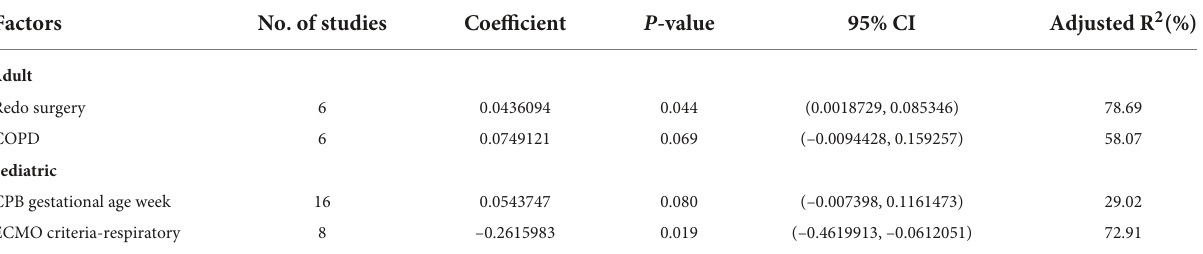
TABLE 1 Meta-regression analysis in adults and